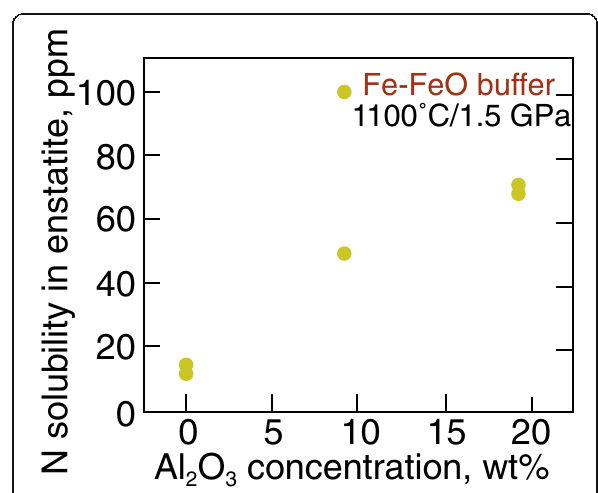
Fig. 7 Nitrogen solubility in enstatite as a function of its Al 2 O 3 content at fixed temperature, pressure, and oxygen fugacity as indicated on the figure (modified from Li et al.